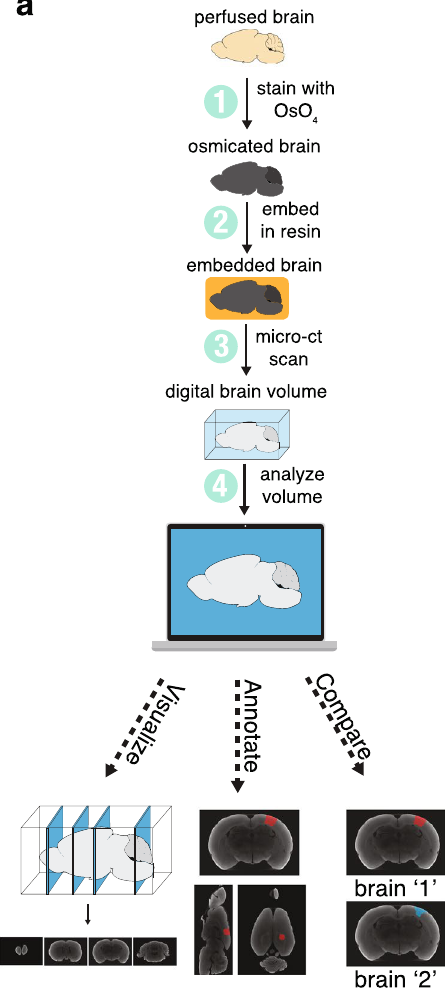
Figure 1. Method overview. ( a ) Overview of the steps required to prepare and analyze a whole brain using micro-CT